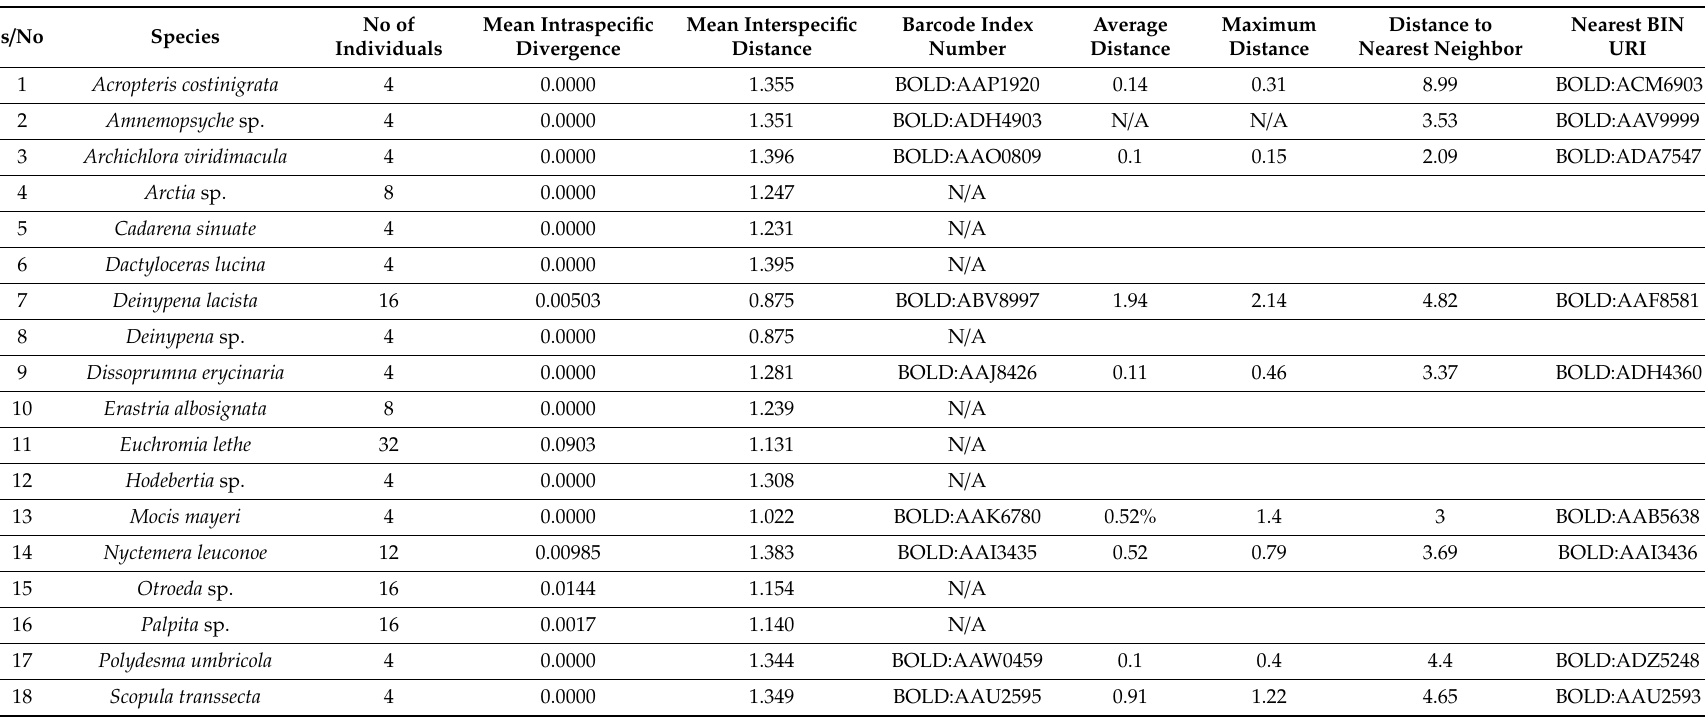
Table 1. Mean Intra and interspecific genetic distances and Barcode Index Number details for species of moths from